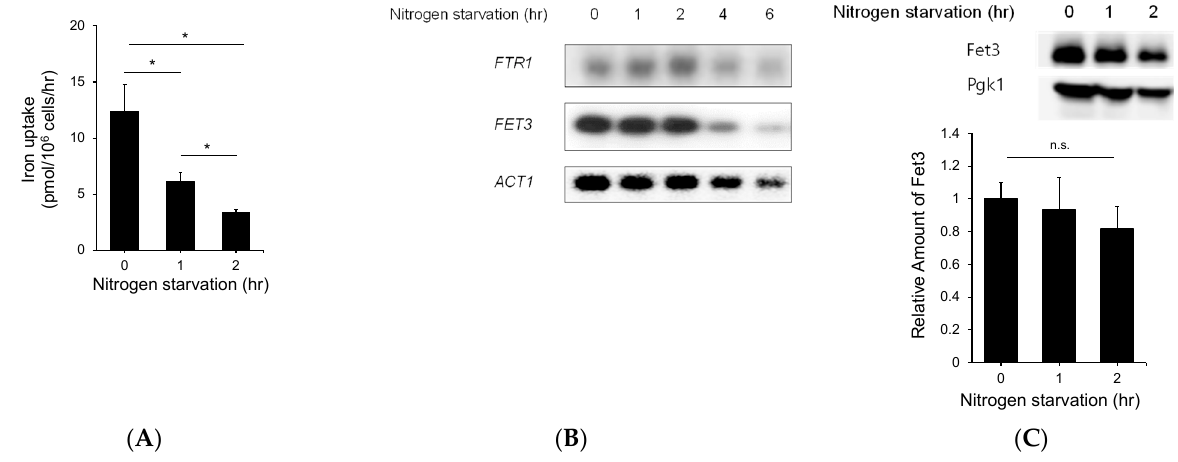
Figure 2. The expression of genes involved in high-affinity iron uptake is not affected by nitrogen starvation. ( A ) The wild-type strain of S. cerevisiae was cultured in YPD medium, and nitrogen starvation was performed as described in the Materials and Methods section for the indicated times. In addition, an iron uptake assay was performed. ( B ) The expression of the genes involved in the high-affinity iron uptake system, namely FTR1 and FET3, was investigated. The wild-type cells were starved of nitrogen for the indicated times, total RNA was extracted, and then northern blotting was performed for the indicated genes. ( C ) Additionally, western blotting was performed to confirm the protein level of Fet3 under nitrogen starvation. The wild-type cells were starved of nitrogen for the indicated times, total proteins were extracted, and then, western blotting was performed for Fet3. The expression of the protein was showed quantitatively. n.s., not significant; *: p < 0.05 indicates a significant difference compared to 0 nitrogen starvation time.